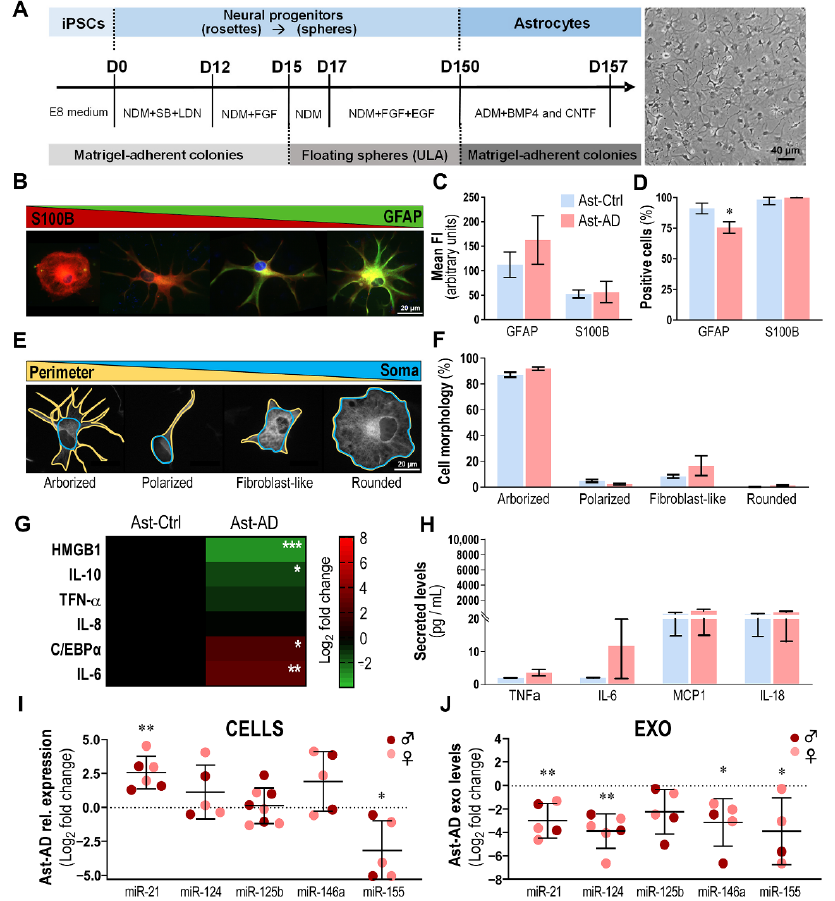
Figure 6. Ast-AD cells show fewer GFAP-positive cells and dysregulated immune-related markers, together with dissimilar miR-21 profiles in cells and exosomes. ( A ) Schematic representation of iPSC differentiation into induced astrocytes (Ast), as detailed in Materials and Methods. ( B ) Astrocytes display a range from almost exclusively S100B+ cells to GFAP+ cells. Nuclei were counterstained with Hoechst. ( C ) GFAP and S100B mean fluorescent intensities (FIs) of Ast-Ctrl and Ast-AD cells. ( D ) Number of GFAP- and S100B-positive cells in Ast-Ctrl and Ast-AD cells. ( E ) Morphological di- versity of astrocytes based on the cell perimeter (yellow outline) and cell soma (blue outline). Cells with more than two branches were considered arborized; cells with a single branch and an acentric nucleus were classified as polarized; cells with no ramifications and an irregular shape were con- sidered fibroblast-like; and cells with a circular shape were classified as rounded. ( F ) Percentage of arborized, polarized, fibroblast-like and rounded AD and Ctrl astrocytes. ( G ) Heatmap representa- tion of differentially expressed immune-related genes in Ast-AD vs. Ast-Ctrl cells. ( H ) Inflamma- tory-associated cytokine profile in the secretome of Ast-AD cells vs. that of Ast-Ctrl cells, deter- mined by LEGENDplex flow cytometry assay. ( I ) Cell quantification of inflamma-miRNAs in Ast- AD vs. Ast-Ctrl (dotted line) in cells and ( J ) in exosomes, expressed as the binary logarithm of the obtained fold change. No differences in AD samples were found between male/female miRNA data. Scale bars correspond to 40 µm ( A ) and 20 µm ( B , C ). Results are mean ± SEM from at least five independent experiments. Two-tailed Student’s t -test: * p < 0.05, ** p < 0.01 and *** p < 0.001, Ast-AD vs. Ast-Ctrl, for all. iPSC, induced pluripotent stem cells; D, days; Ast, iPSC-induced astrocytes; AD, Alzheimer’s disease; Ctrl, control; EXO, exosomes; NDM, neural differentiation media; SB, SB431542; LDN, LDN193189 dihydrochloride; FGF, fibroblast growth factor; EGF, epidermal growth factor; ADM, astrocyte differentiation medium; BMP4, bone morphogenetic protein 4; CNTF, ciliary neurotrophic factor; ULA, ultra-low-attachment plate; HMGB1, high-mobility group